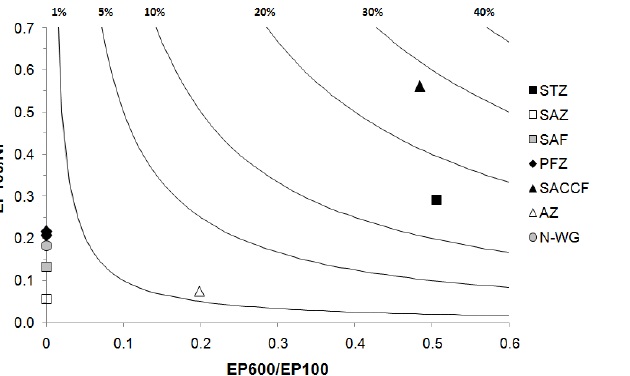
Fig. 11. Ratio of the POC export flux at 600m over the export flux at 100m (EP600/EP100) versus the ratio of the export flux at 100m over new production (EP100/NP). Isolines represent the modelled 1, 5, 10, 20, 30 and 40% of NP exported to depths > 600m. Note: EP600 = EP100 – Remineralised C flux; EP100 and remineralised C flux estimated using the 234Th approach; negative EP600 fluxes were set to zero. NP from Joubert et al.